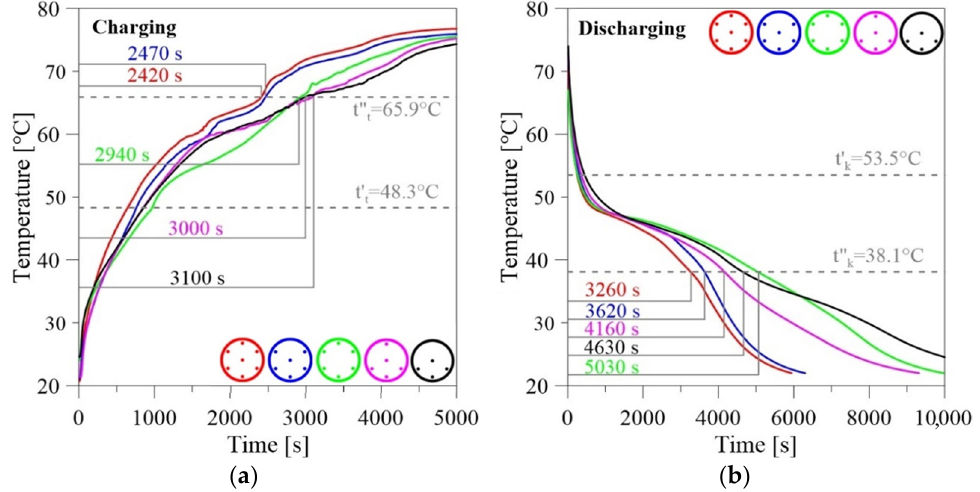
Figure 5. Effect of the number of tubes for P1808: ( a ) charging; ( b ) discharging.